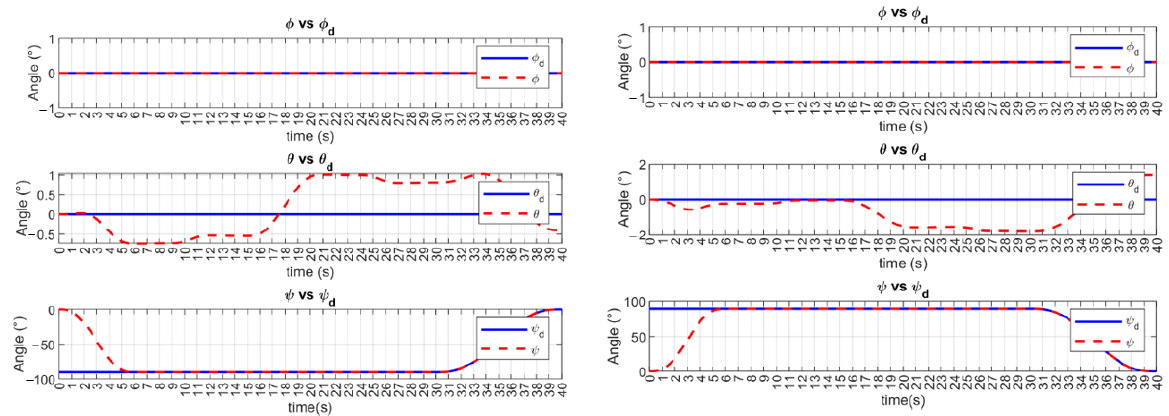
BlueROV2 #2 ( right ).